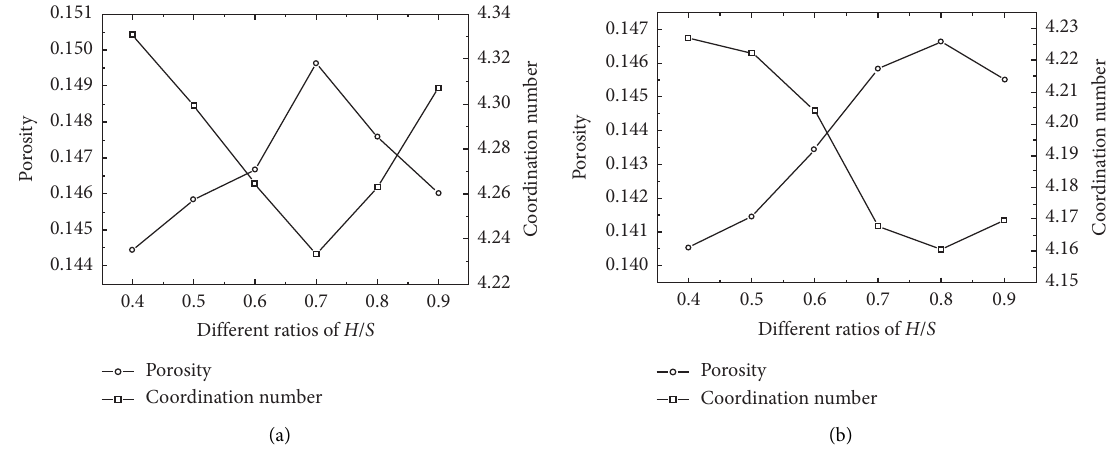
Figure 13: Variations of porosity and coordination number on top of CCT for cases (a) S1 and (b)